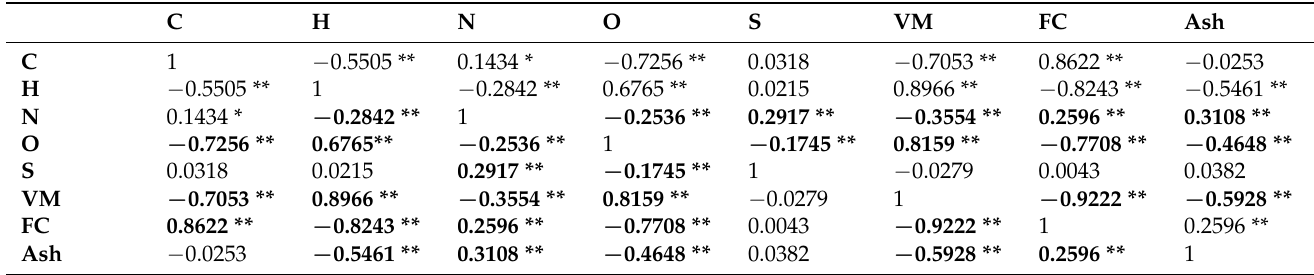
Table 2. Result of Pearson correlation between C, H, N, O, S, VM, FC, and Ash.